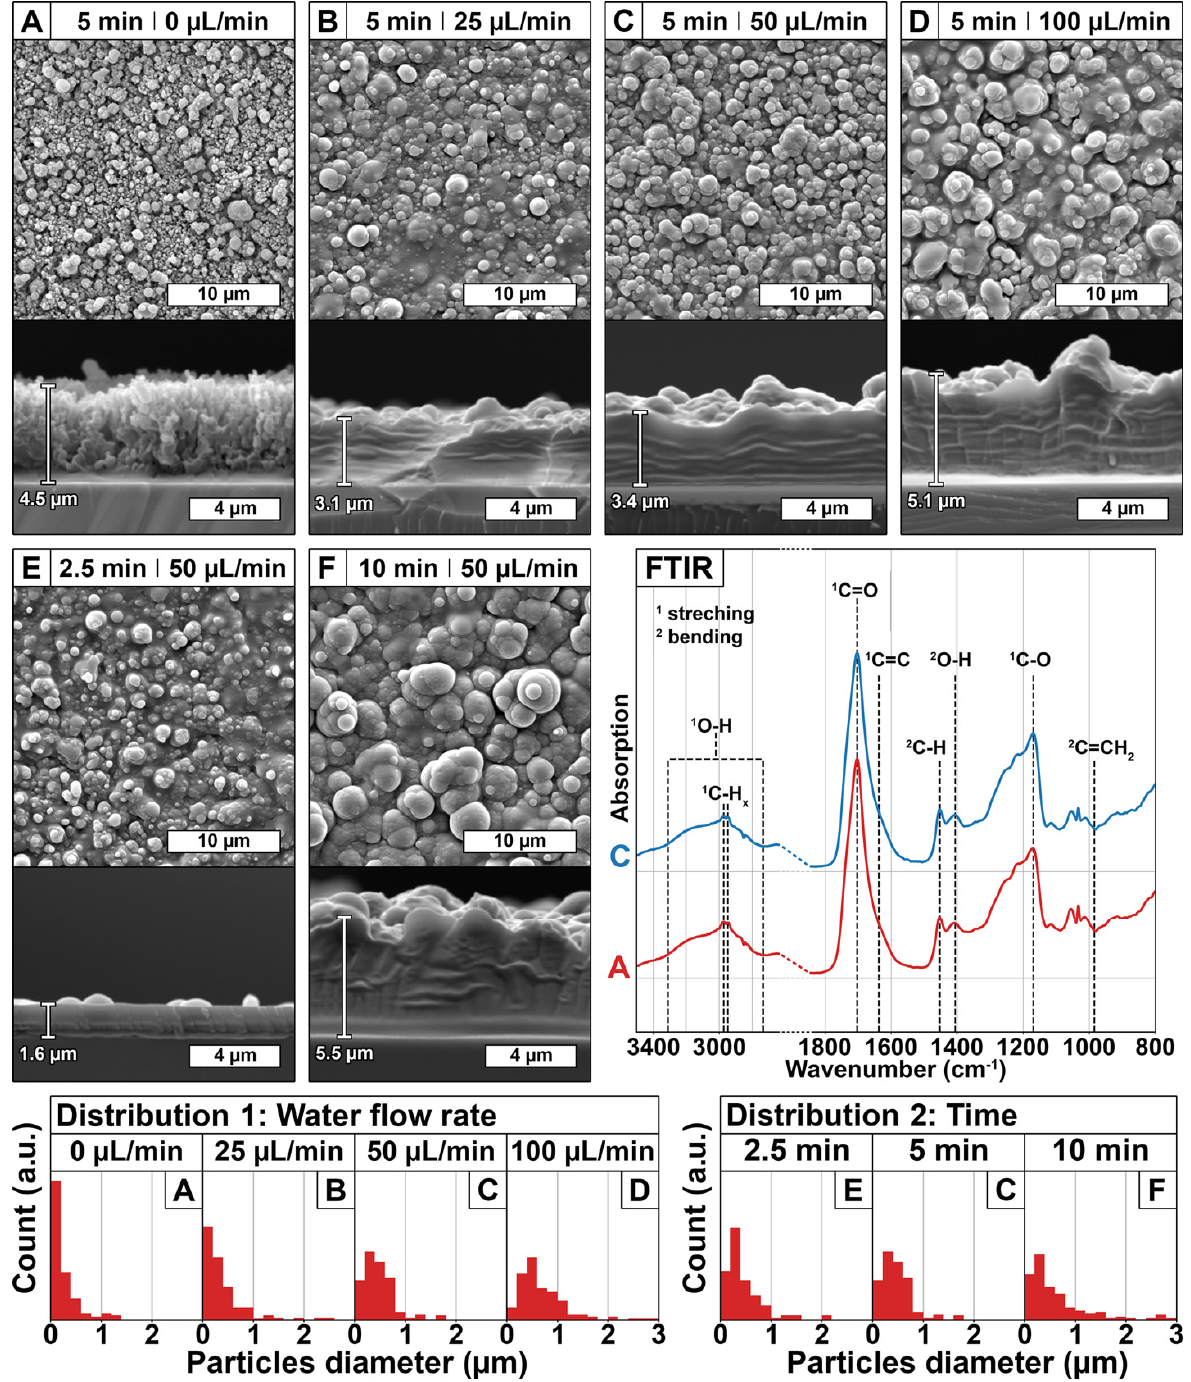
Figure 2. Scanning electron microscopy images of coatings surface morphology (×5000) and cross-section (×10,000) deposited with different water flow rate: 0 µL/min ( A ), 25 µL/min ( B ), 50 µL/min ( C ), and 100 µL/min ( D ); and for different time: 2.5 min ( E ), 5 min ( C ), and 10 min ( F ). Influence of plasma parameters, water flow (Distribution 1) and deposition time (Distribution 2), on the distribution of particles diameter, done on 200 particles. Fourier-transform infrared spectra of coatings chemistry deposited without water flow rate (FTIR, A, red spectrum), and with 50 µL/min water flow rate (FTIR, C, blue spectrum), and identification of major bonds signal.